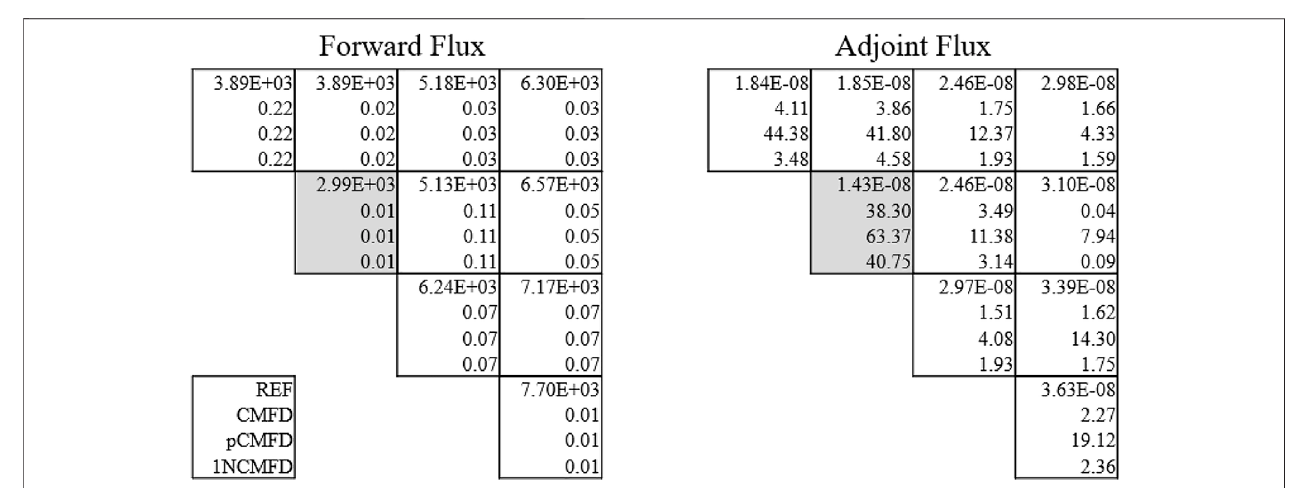
FIGURE 6 | Percentage error for forward and adjoint fl uxes with a node size of 20